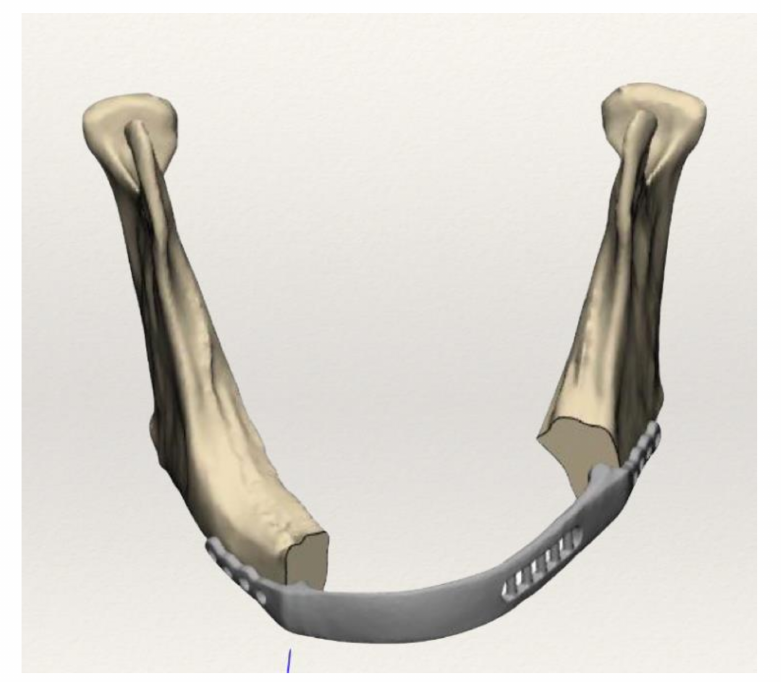
Figure 3. Virtual reconstruction. A grid is created in the body portion of the plate to anchor the oral pelvi